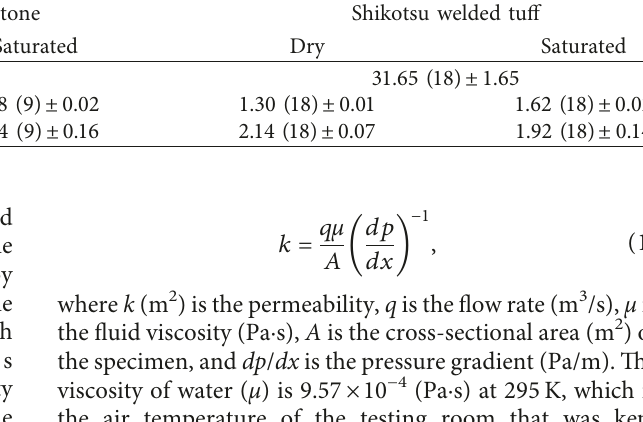
Table 3: Physical properties of the rock samples shown as the average value (number of specimens) ± standard deviation. Properties